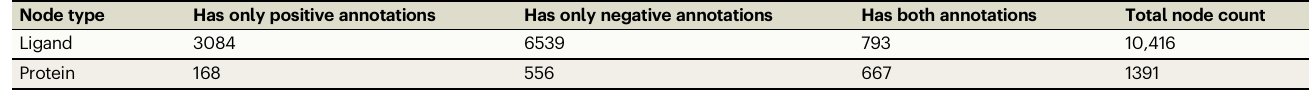
Table 1 | BindingDB training data for DeepPurpose Node